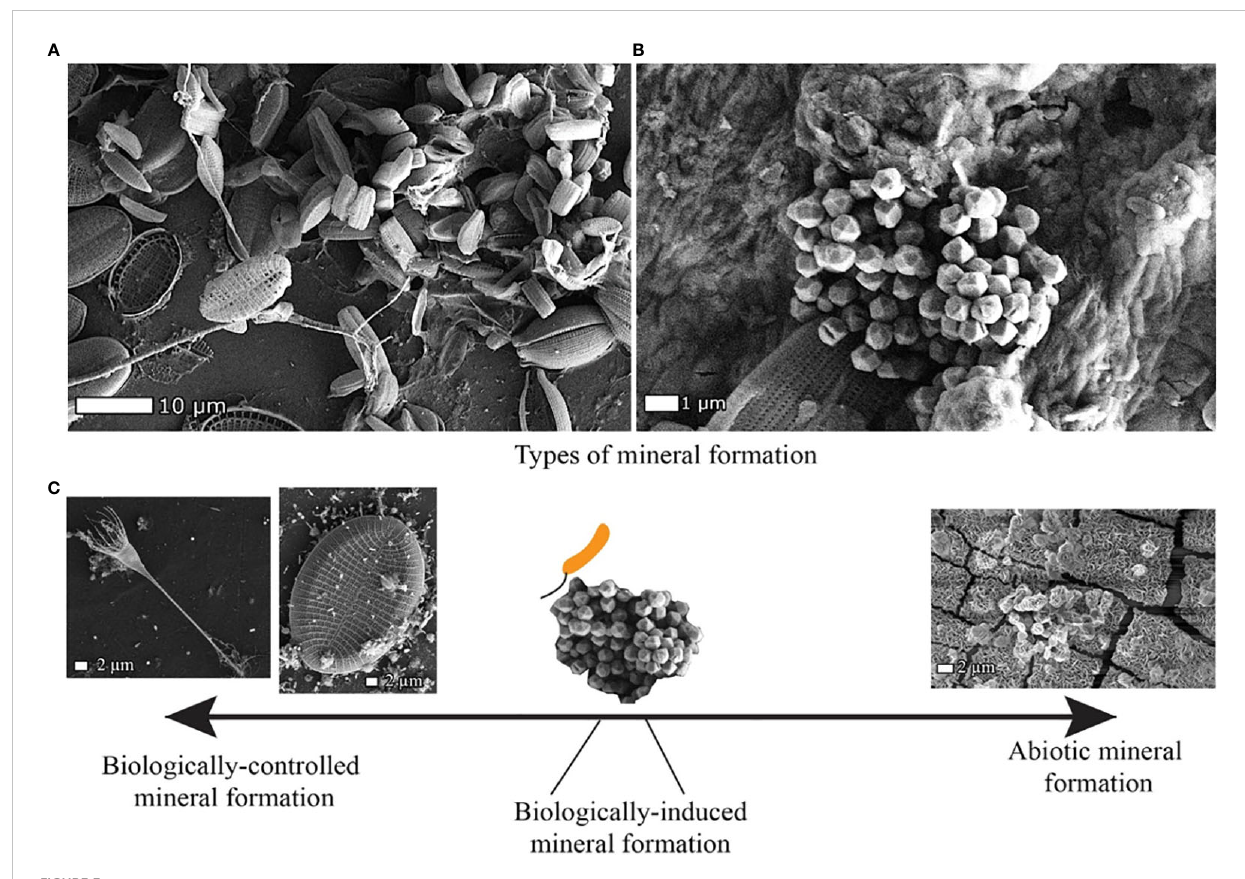
FIGURE 3 Plastics exposed to water column and sediment of Svanemøllen Harbour, Denmark, show the close association of microorganisms as well as biogenic and abiogenic minerals in SEM-SE micrographs. (A) PS exposed to water column for 3 months colonized by diatoms and (B) PS exposed to top sediment (0-2 cm depth) for 6 months shows incorporation of pyrite framboids into bio fi lm also consisting of diatoms, bacillus and coccoid encrusted in granular fi lm. (C) Minerals can form through different processes that can be conceptualized along a spectrum from biologically- controlled to fully abiotic processes (Konhauser et al., 2007). Examples of these different types of mineral formation are seen within the microbe- mineral bio fi lm matrix on